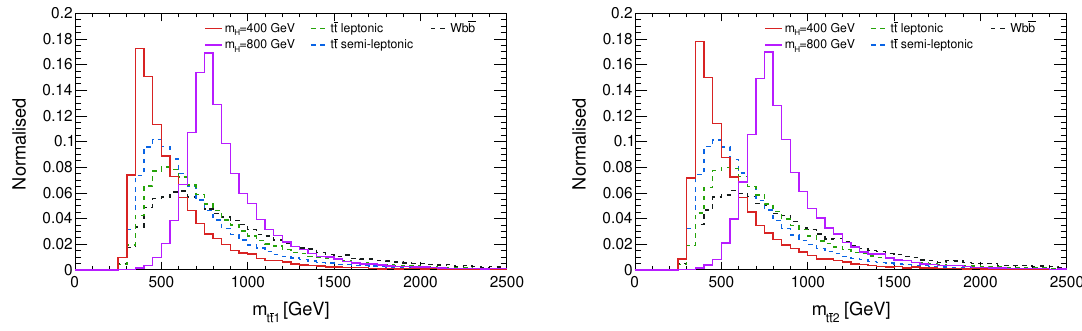
Figure 32 . The reconstructed invariant mass of the top-quark pair in the semi-leptonic decay of the H t (cid:22) t !